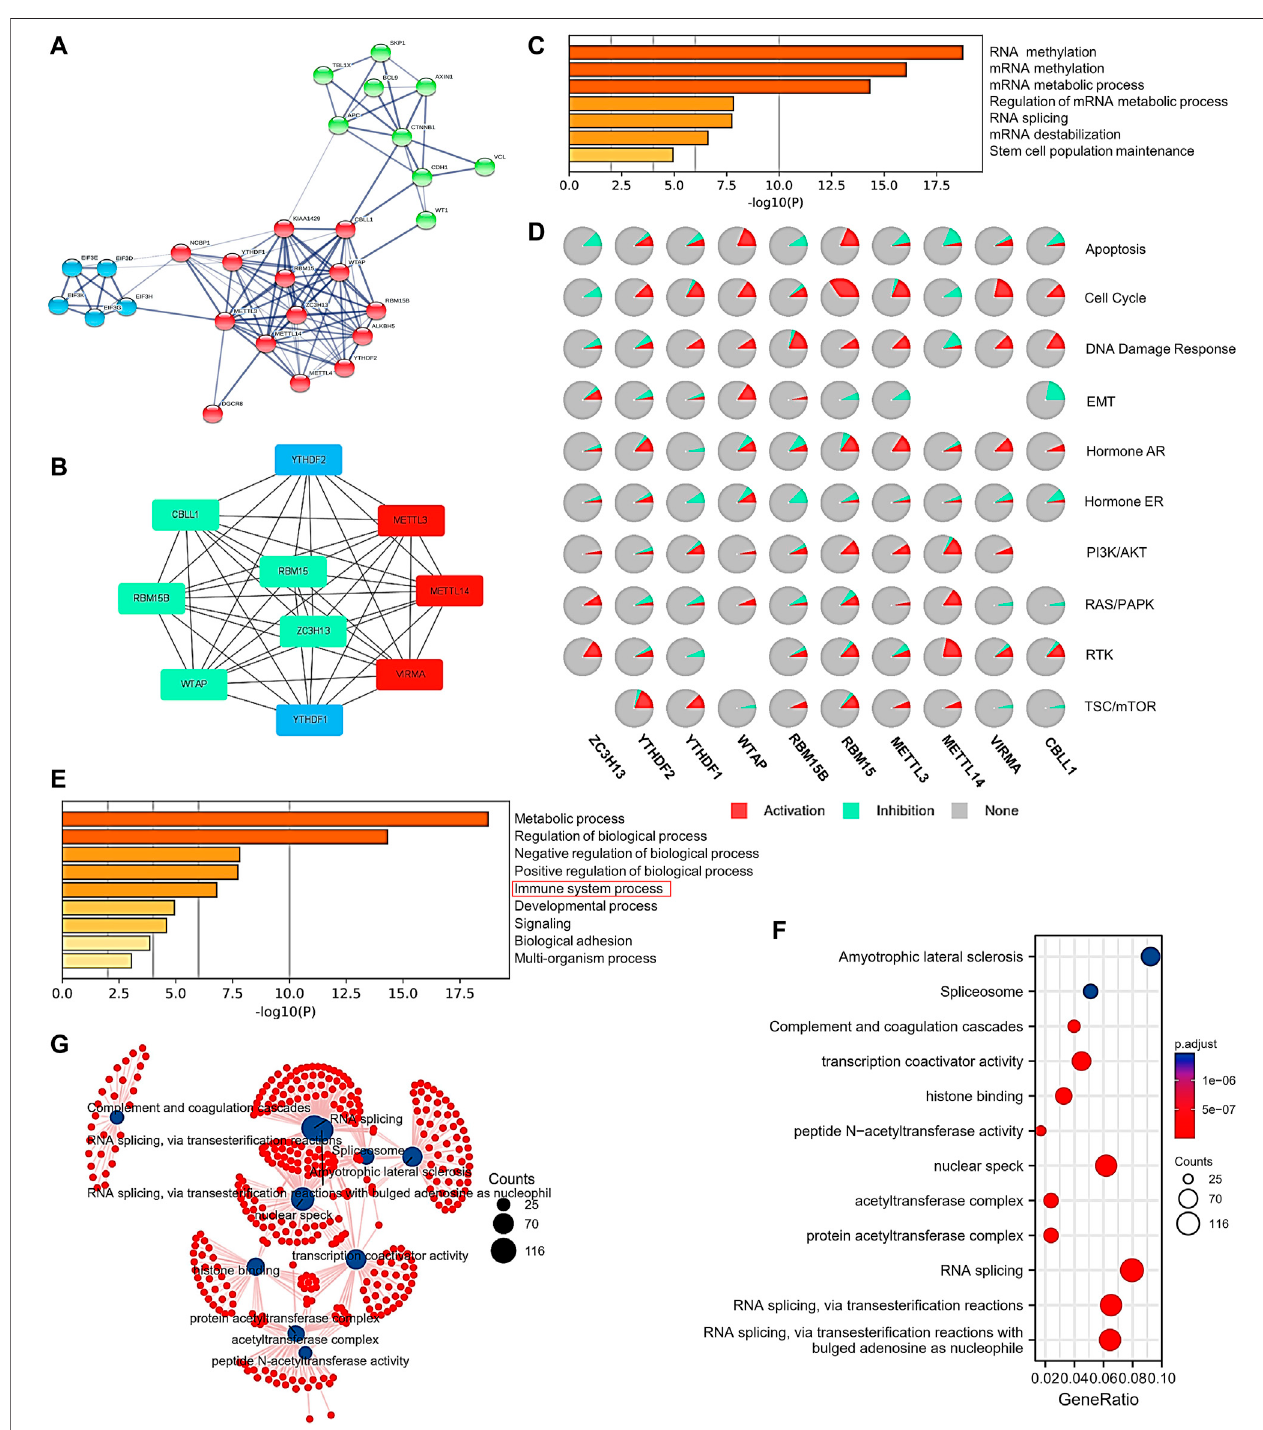
FIGURE8| Protein – proteininteractions(PPIs) andfunctionalenrichment analysisofthem 6 Awriter complexinHCC. (A) PPInetworkofthetop 20proteins related to the m 6 A writer complex in HCC (STRING). (B) Ten hub genes selected by Cytoscape from the PPI network. Red represents high degree value of the gene. Blue represents the hub genes except for the writer complex components. (C) Molecular function enrichment of the hub genes (Metascape). (D) Pathway enrichment of the hub genes(GSCALite). (E) Biologicalprocess enrichment ofthehub genes(Metascape). (F) GeneOntology(GO)andKyotoEncyclopediaofGenesandGenomes (KEGG) pathway enrichment analysis of the writer complex and the top 200 coexpressed genes. (G) Network for GO and KEGG pathway enrichment.